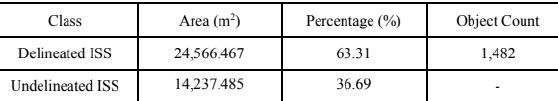
Table 3. Summary of ISS delineation done in eCognition.